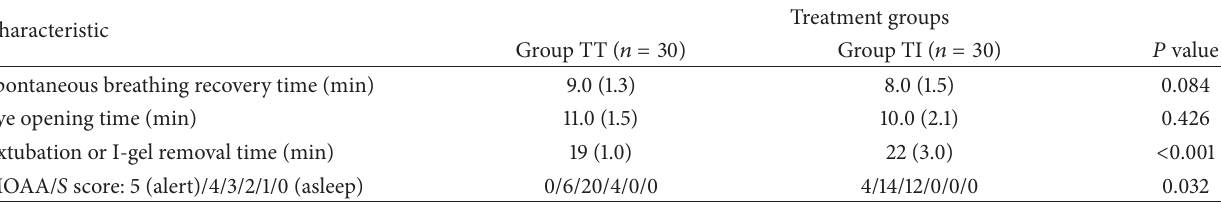
Table 2: Spontaneous breathing recovery time, eye opening time, extubation or I-gel removal time, and MOAA/ 𝑆 score.